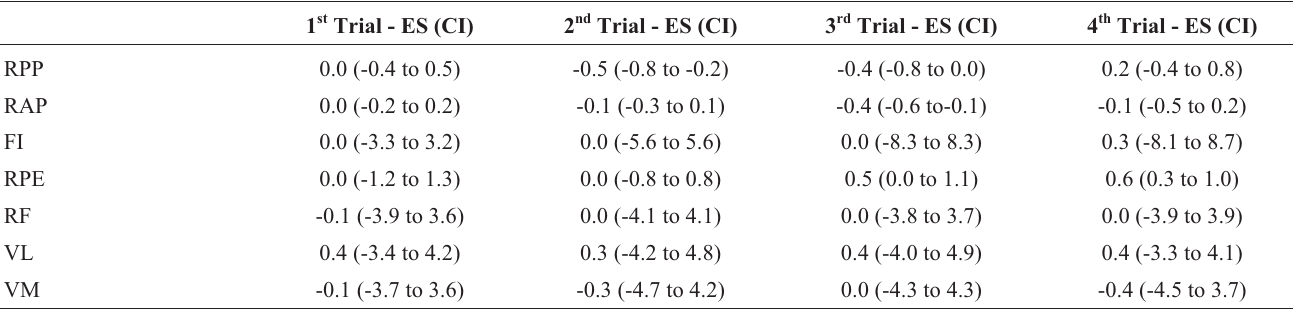
Table 1 - Effect size results between anodal and sham